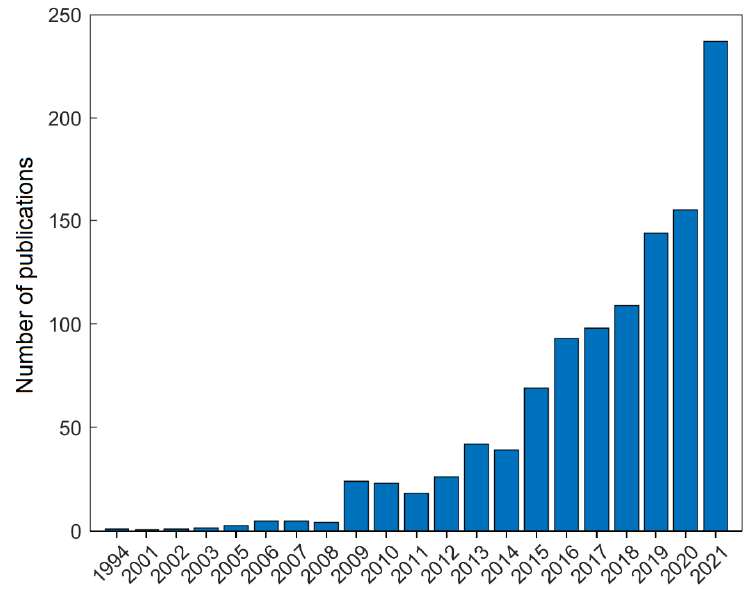
Figure 1. The overall trend for the number of publications in AI on bioenergy research.